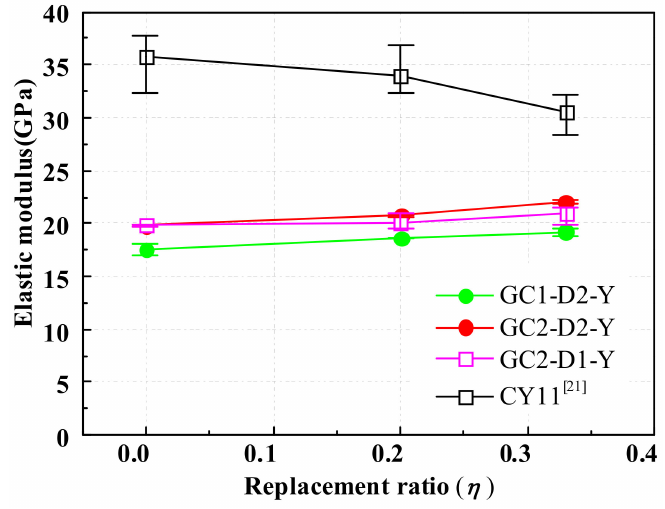
Figure 11. Elastic modulus of GRLC and CRLC